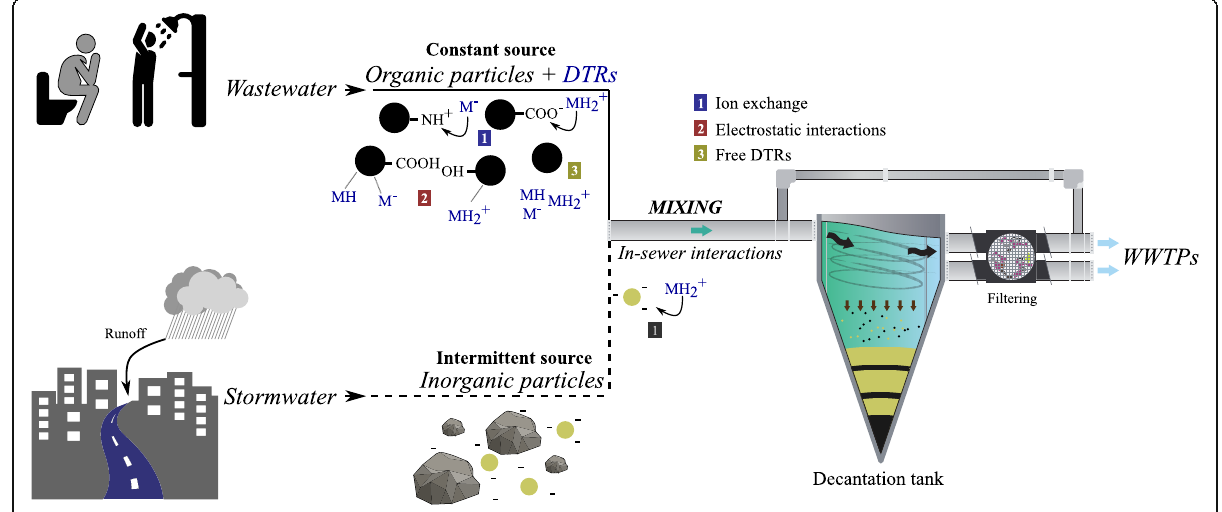
Fig. 7 Schematic representation of the origin and possible reactivity of solids sampled in the decantation